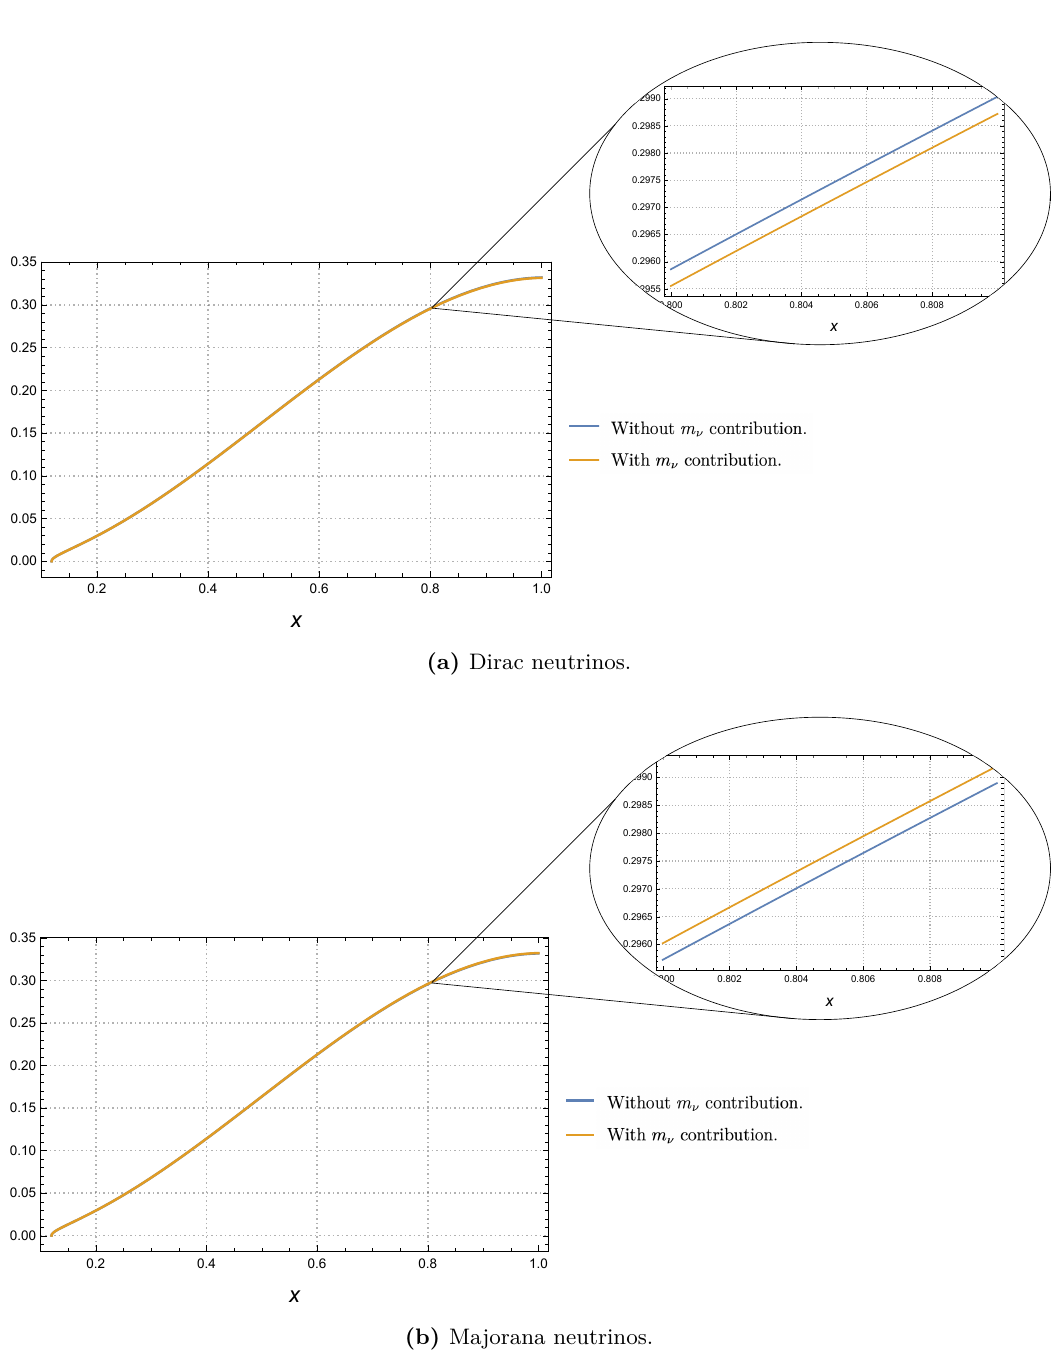
Figure 5. Neutrino mass effect on the energy spectrum of the final